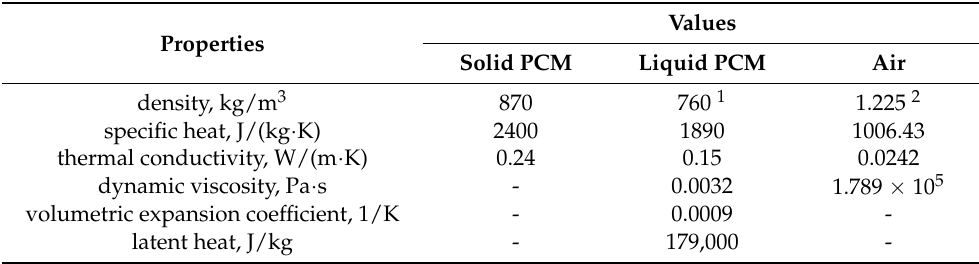
Table 1. Thermophysical properties.